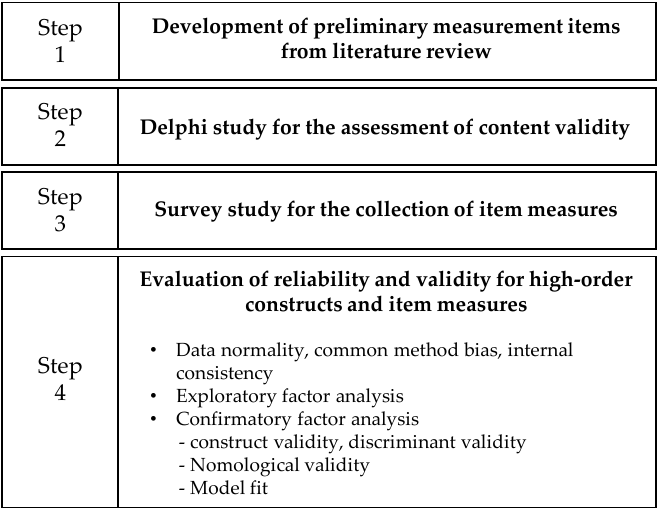
Figure 1. Research flow for the present work.